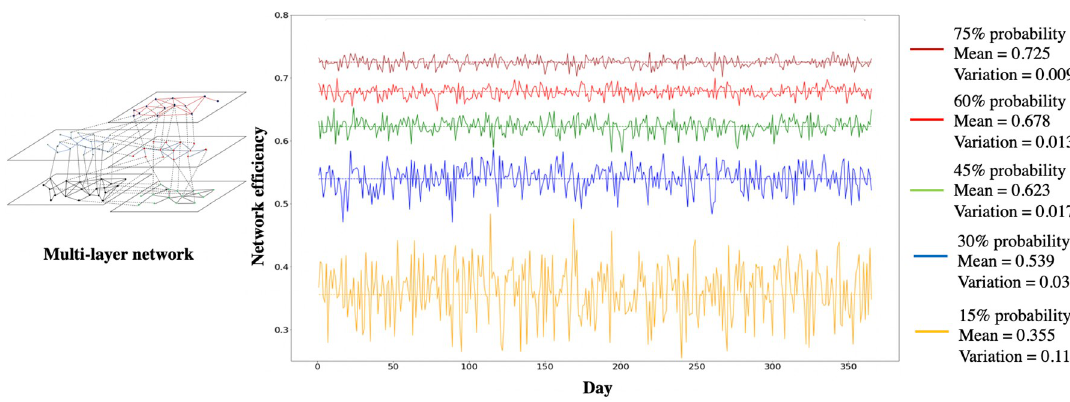
Fig 7. Network efficiency and coefficient of variation with different daily coordination probabilites.